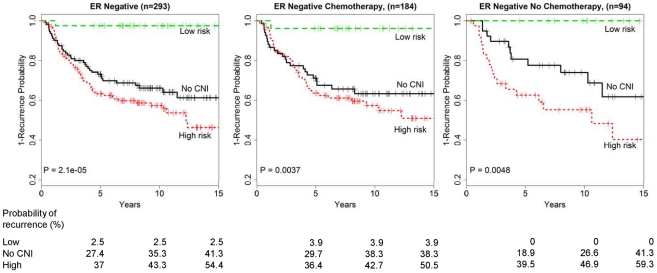
Kaplan-Meier analysis of the recurrence probability by CNI-only risk categories for ER− cases by treatment.
(A) all; (B) received chemotherapy; and (C) no chemotherapy.